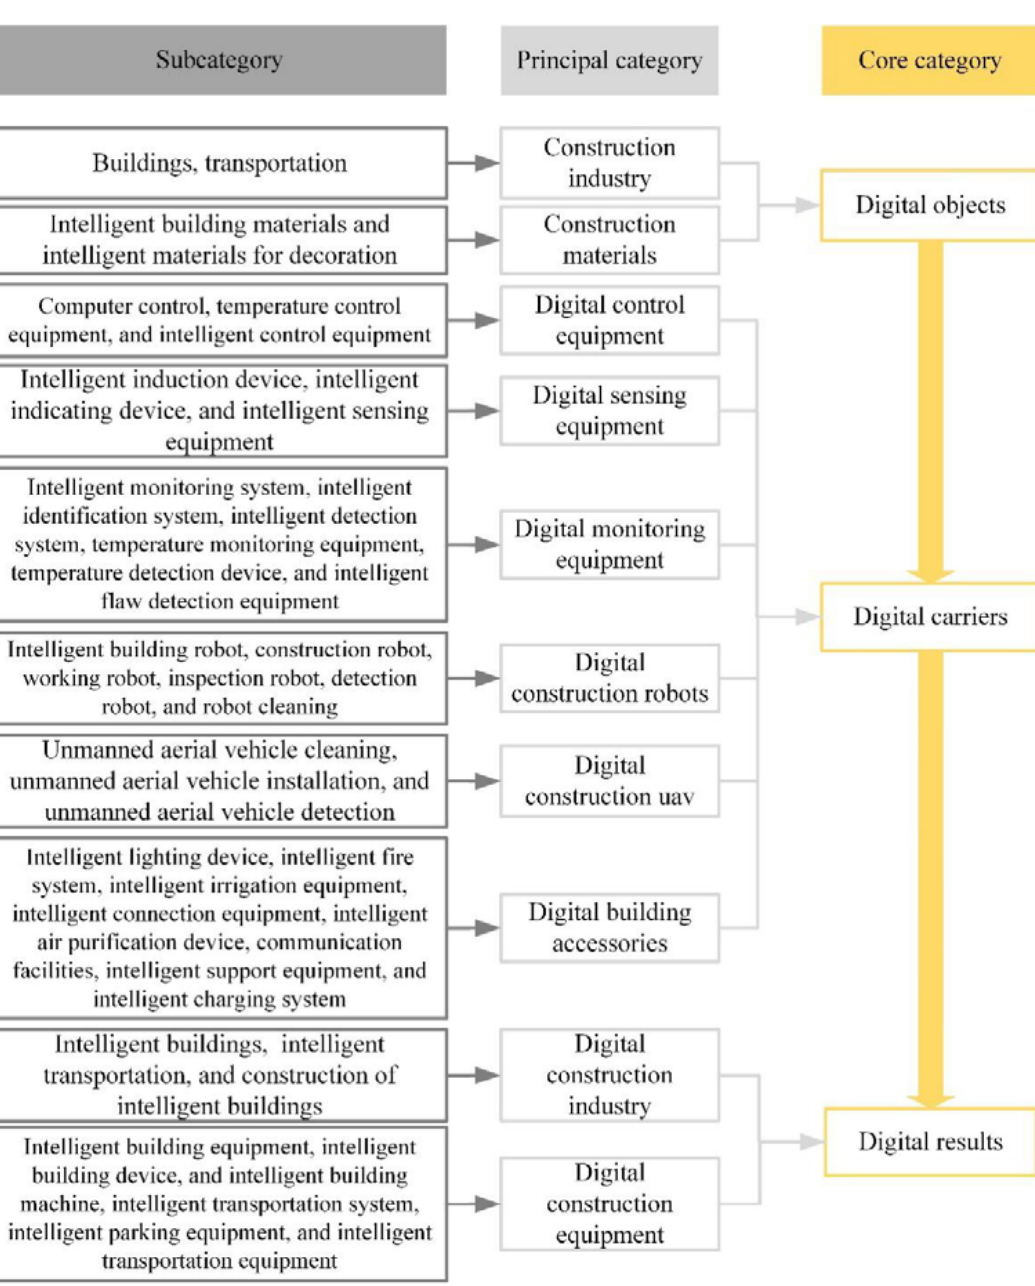
Figure 13. Coding procedure and results for patents in the digital construction industry.